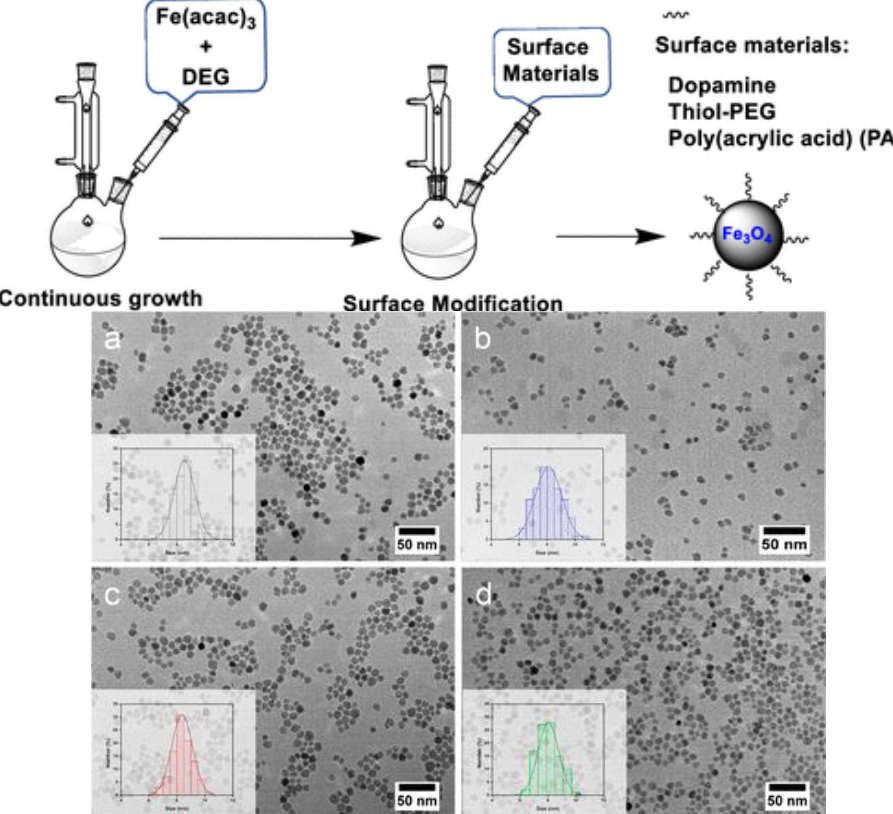
Figure 10. ( Top ) Synthesis of Fe 3 O 4 NPs in diethylene glycol (DEG) by thermal decomposition of acetylacetonate (Fe(acac) 3 ), and surface modification by adding surface ligands. ( Bottom ) TEM images of Fe 3 O 4 NPs ( a ), Fe 3 O 4 NPs functionalized with dopamine ( b ), Fe 3 O 4 NPs surface modified with polyethylene glycol with thiol end group (thiol-PEG) ( c ), and Fe 3 O 4 NPs modified with poly(acrylic acid) (PAA) ( d ). Adapted from ref. [84], copyright 2021, with permission from the American Chemical Society.